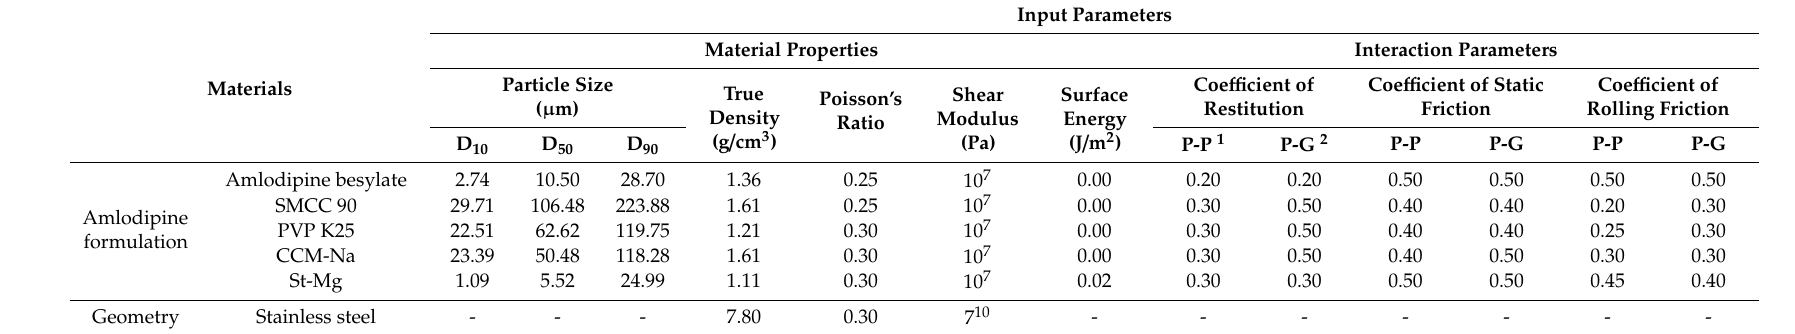
Table 7. Input parameters defined through direct measurement and calibration